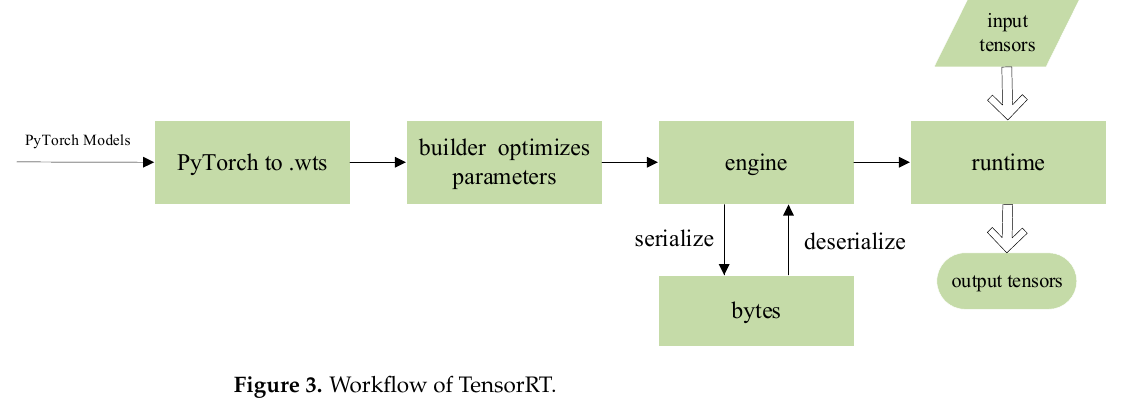
Figure 3. Workflow of TensorRT.